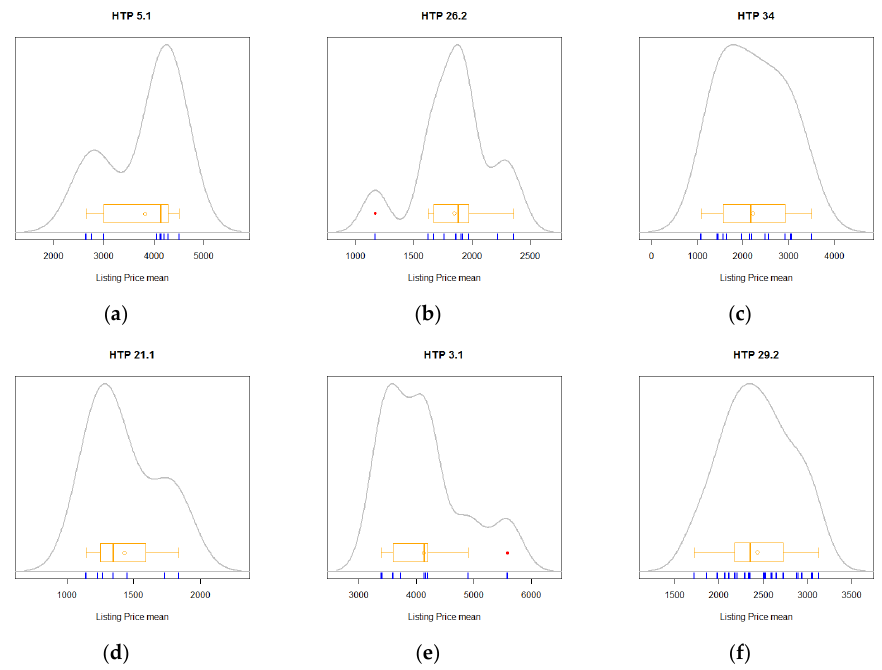
Figure 3. Kernel density plot and LP box plot (measured in Euro per square metre): ( a ) HTU 5_1 subsample; ( b ) HTU 26_2 subsample; ( c ) HTU 34 subsample; ( d ) HTU 21_1 subsample; ( e ) HTU 3.1 subsample; ( f ) HTU 29.2 (Source: Authors’ elaboration on TREMO